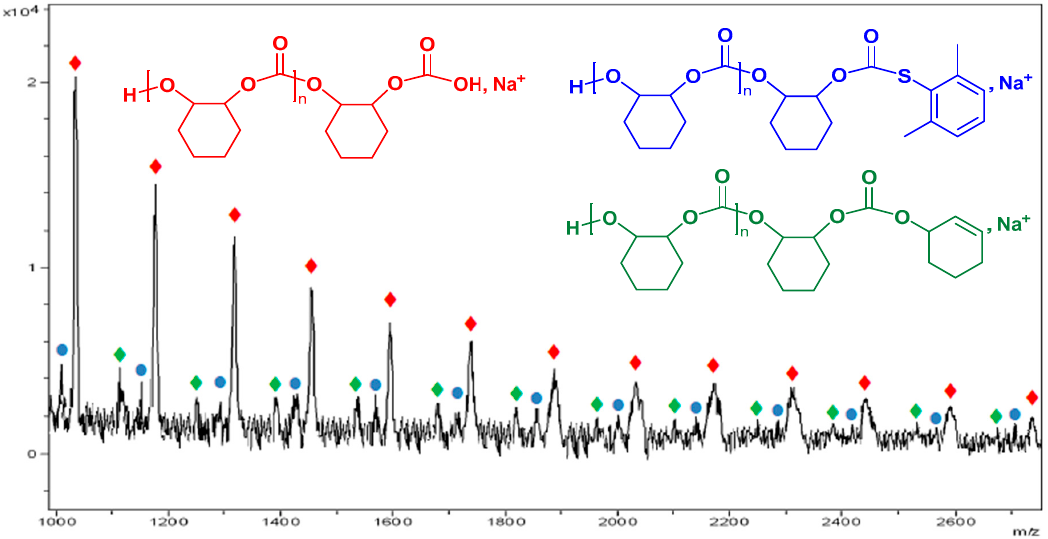
Figure 4. MALDI-ToF mass spectrum of poly(cyclohexene carbonate) sample from Table 4 (entry 2) using zinc complex 4 as catalyst at 70 °C and 10 bar CO 2 . Series ♦ has a repeat unit m / z = 1+ (142.07 × DP n+1 ) + 17 + 22.98, where n = 6–18. Series ● has a repeat unit m / z = 1+ (142.07 × DP n+1 ) + 137.14 + 22.98, where n = 5–17. Series ♦ has a repeat unit m / z = 1+ (142.07 × DP n+1 ) + 97.05 + 22.98, where n = 6–17.